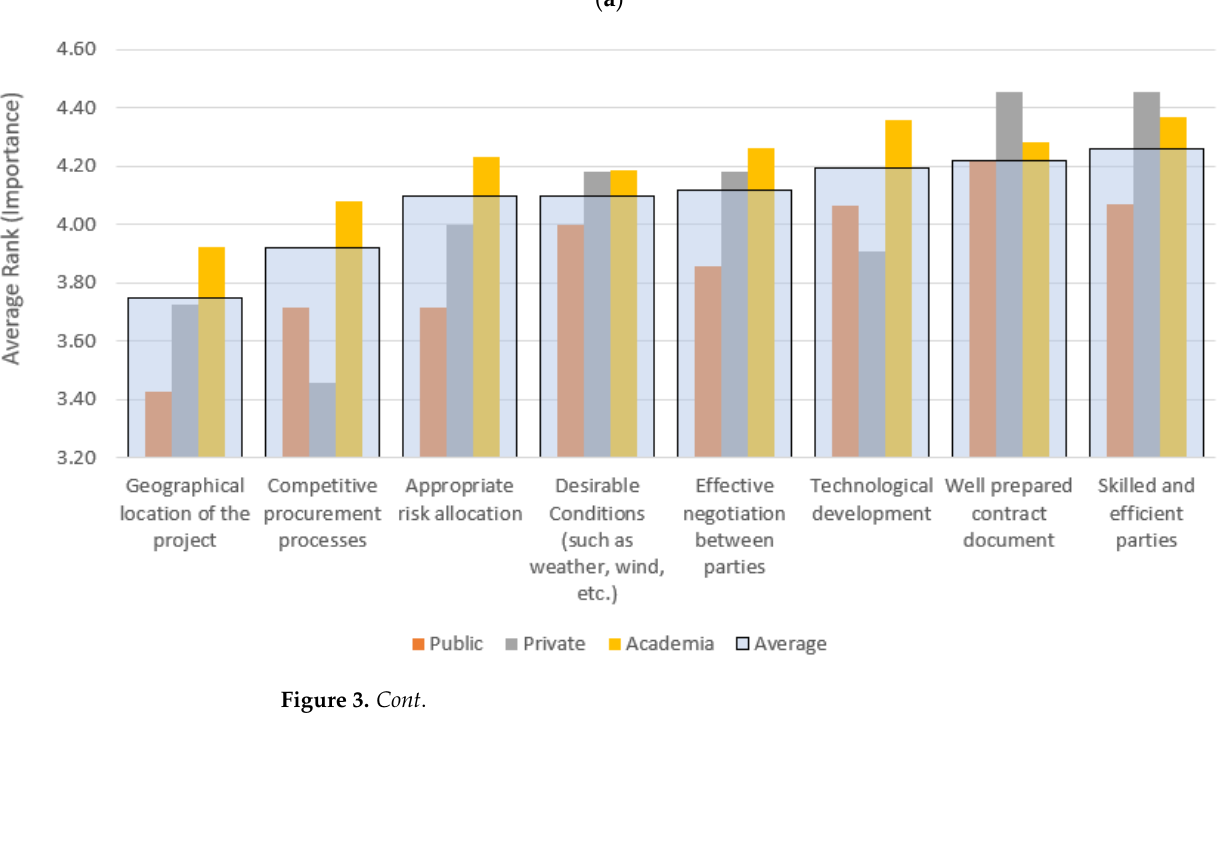
Figure 3. ( a ) Key success factors and ( b ) key success indicators of renewable-energy PPPs as per- ceived by the different sectors. Although the previous discussion focused mainly on understanding the factors for the success of renewable-energy projects, it is also crucial to choose the right parameters and tools for quantifying or evaluating the level of success of these projects. Thus, the experts were asked to rank the key performance indicators (KPIs) in terms of their im- portance in evaluating renewable-energy PPPs on a Likert scale from 1 to 5, as shown in Figure 3b. In general, the produced energy capacity and reduction in the level of emissions were considered the main KPIs for evaluating the success of renewable-energy PPPs. Ad- ditionally, the results show that each party preferred different KPIs for evaluating their projects. The public sector reported that the resources saved and traditional KPIs (cost,